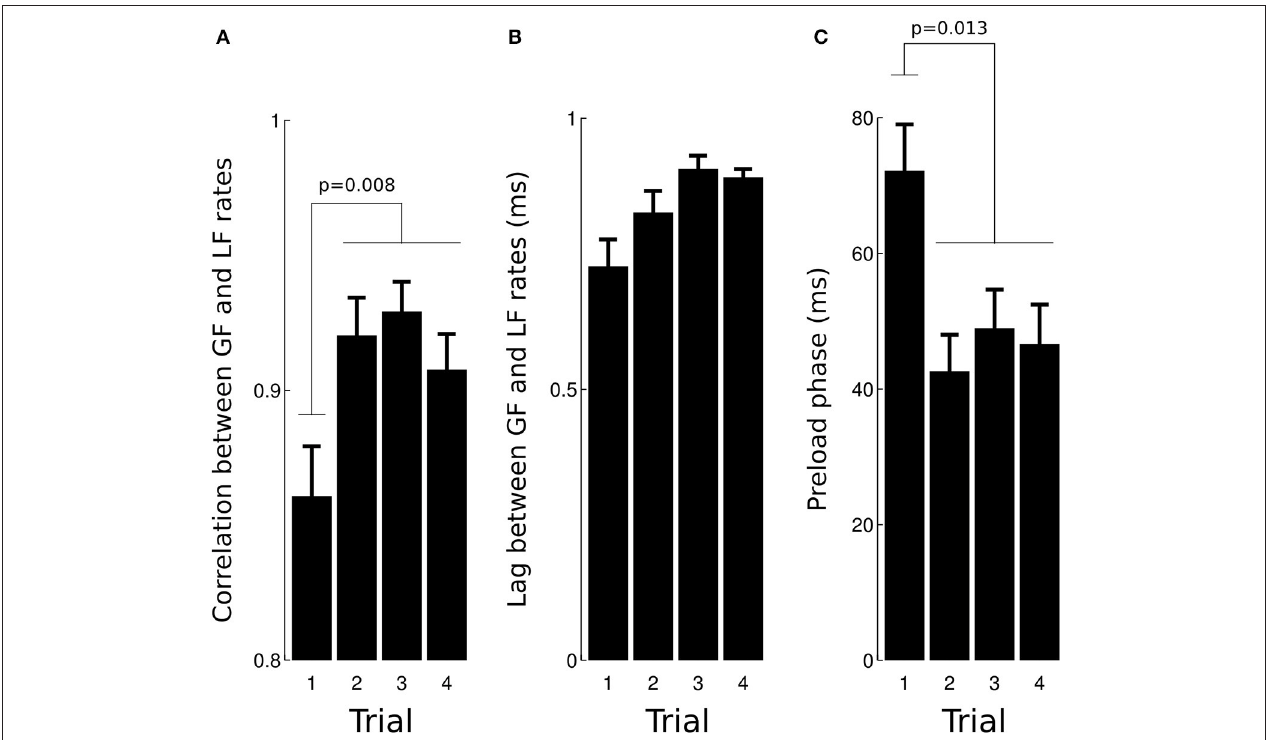
FIGURE 4 | Effects of trial number on the correlation (A) and lag (B) calculated between load force rate and grip force rate during the loading phase. Trial 1 had a lower correlation than trials 2–4. (C) The preload phase was the longest during trial 1 in comparison with trials